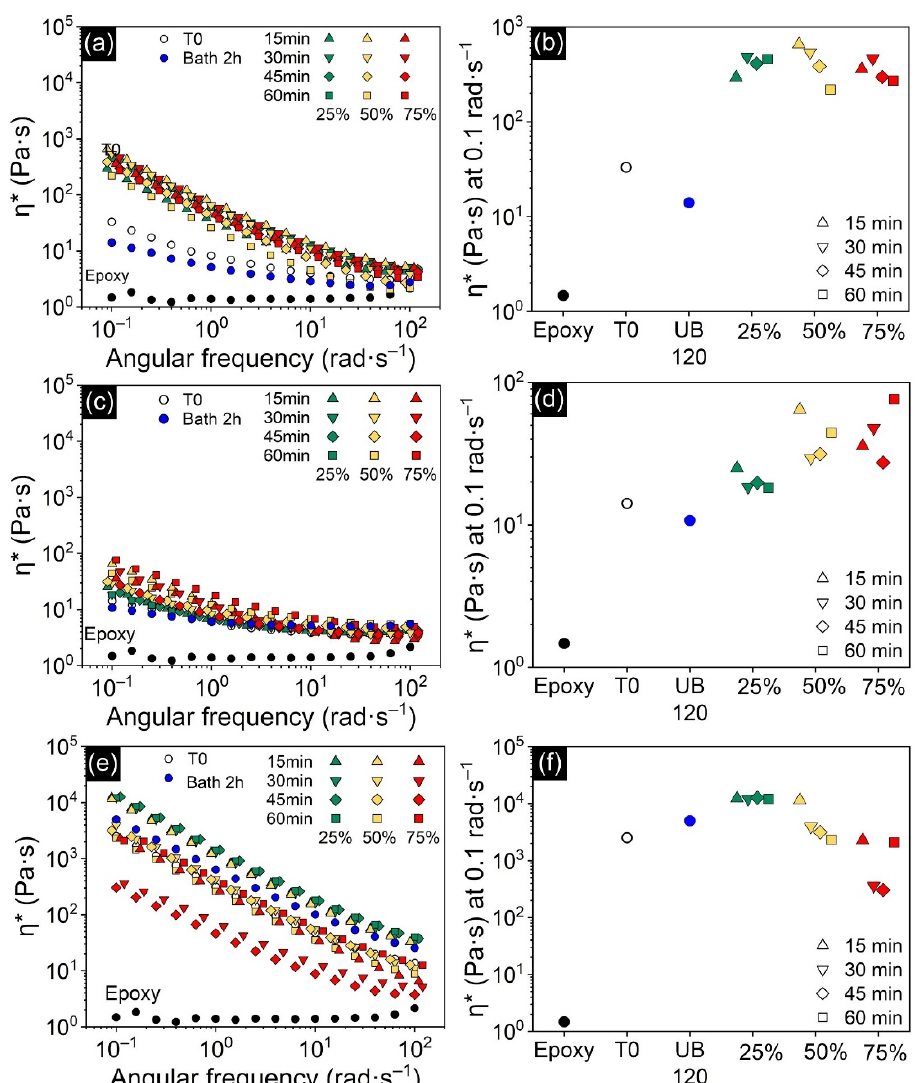
Figure 4. ( a , c , e ) Complex viscosity ( η *) of CNT-epoxy, GNP-epoxy and hybrid-epoxy suspensions, respectively; ( b , d , f ) show η * taken at 0.1 rad·s − 1 as a function of processing method. T0 denotes the unprocessed samples and UB 120 the samples processed in the ultrasonic bath.